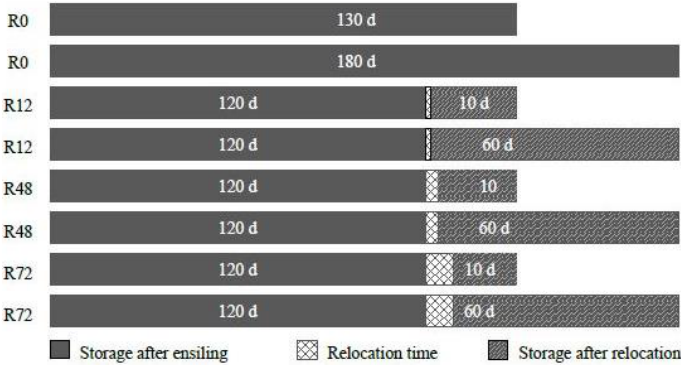
Figure 1. Timelines for sugarcane silage without (R0) or with relocation for 12 (R12), 24 (R24) or 72 h (R72) that is stored for a total of 130 or 180 days.